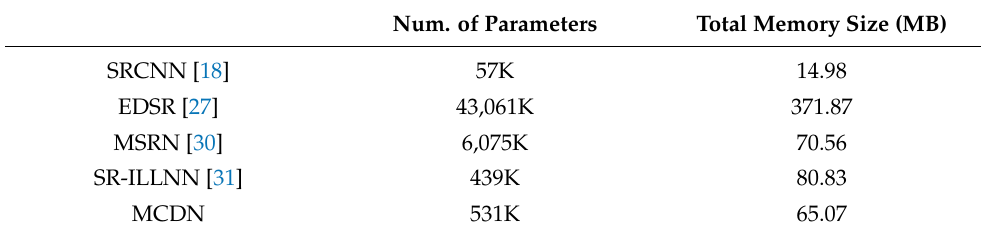
Table 3. The number of parameters and total memory (MB) size.